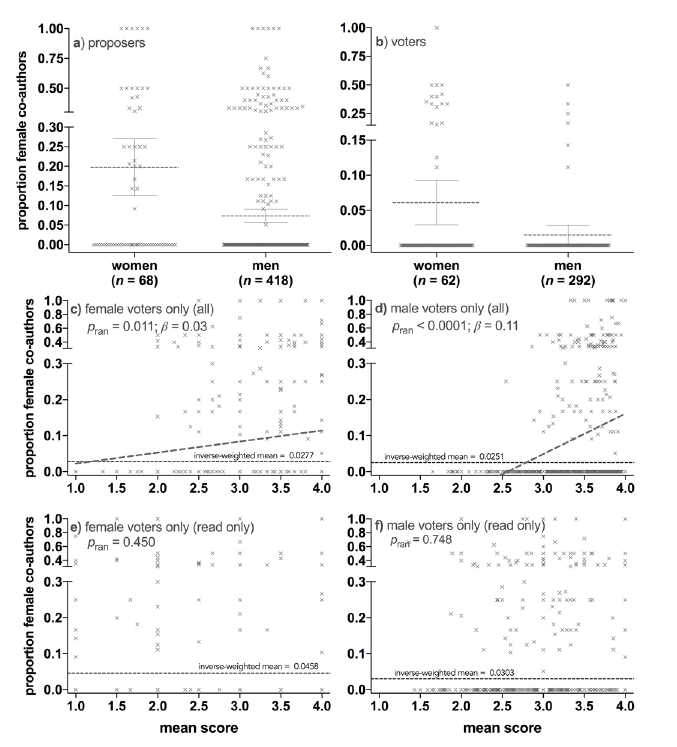
Figure 1. a Mean (dashed horizontal lines) and 95% confidence interval (error bars) of the proportion of female co-authors for the proposed articles relative to the gender of the proposer (articles proposed by 68 women only, and 418 proposed by men only). The values (proportion female co-authors) are ‘scattered’ to show their distribution within each proposer gender; note that 55.9% and 80.1% of the articles proposed by women only and men only, respectively, had no female co-authors (i.e., zero values) b Mean (dashed horizontal lines) and 95% confidence interval (error bars) of the proportion of female co-authors of the 100 top-ranked articles relative to the gender of the voter (62 women and 292 men voted in total). The values (proportion female co-authors) are ‘scattered’ to show their distribution within each voter gender; note that 83% and 94% of the articles proposed by women and men, respectively had no female co- authors (i.e., zero values). c ) Proportion of female co-authors on articles relative to their mean rank (score; where lower scores indicate a higher ranking) when voters were restricted to women. There was a weak ( β = 0.03), but non-random ( p = 0.011) correlation between article gender ratio and score, such that the lower the proportion of female co-authors, the higher they were ranked by women d Proportion of female co-authors on articles relative to their mean rank when voters were restricted to men. There was a stronger ( β = 0.11) and non-random ( p < 0.0001) correlation between article gender ratio and score, such that the lower the proportion of female co-authors, the higher they were ranked by men. Also shown in both panels is the inverse-score-weighted mean proportion of female co-authors ( Σ w / s = 0.0277 for i i i female voters, or 0.0251 for i male voters, where s = score from 1 to 4, and w = proportion of female co- authors) e As in c , but when the scored articles were only those actually read by the voters (Courchamp and Bradshaw 2017) f As in d , but when the scored articles were only those actually read by the voters. The inverse-score-weighted mean proportion of female co-authors for these read-only articles was higher for female-only (0.0458) versus male-only voters